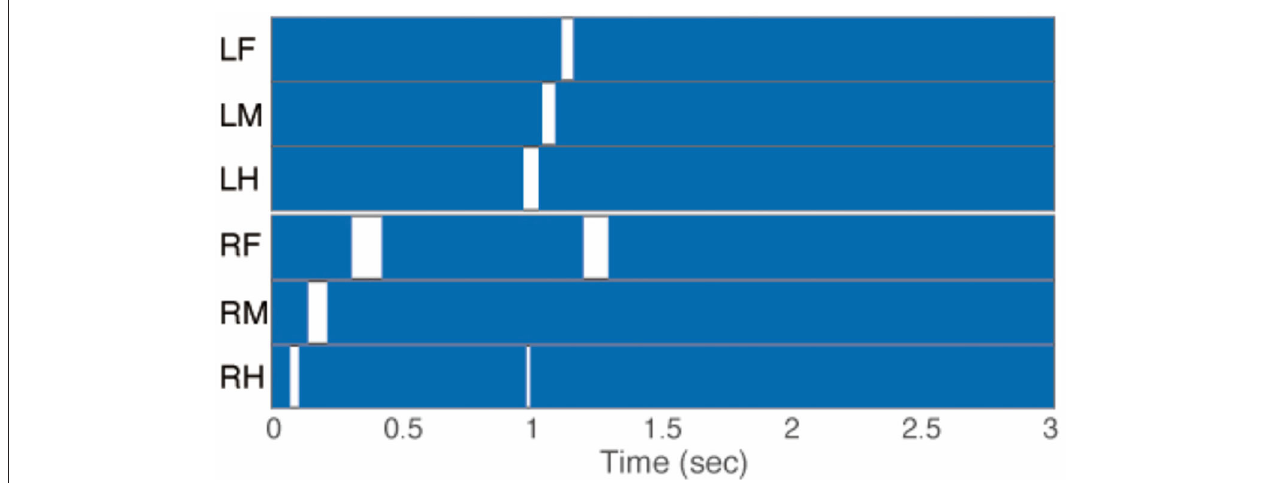
FIGURE 4 | Gait chart diagram of cricket in which paired nerve connectives between SEG and prothoracic ganglion were cut. The filled parts indicate that the tip of the legs touched the floor, demonstrating that the cricket did not walk on the floating ball of the treadmill. LF, left foreleg; RF, right foreleg; LM, left midleg; RM, right midleg; LH, left hind leg; RH, right hind